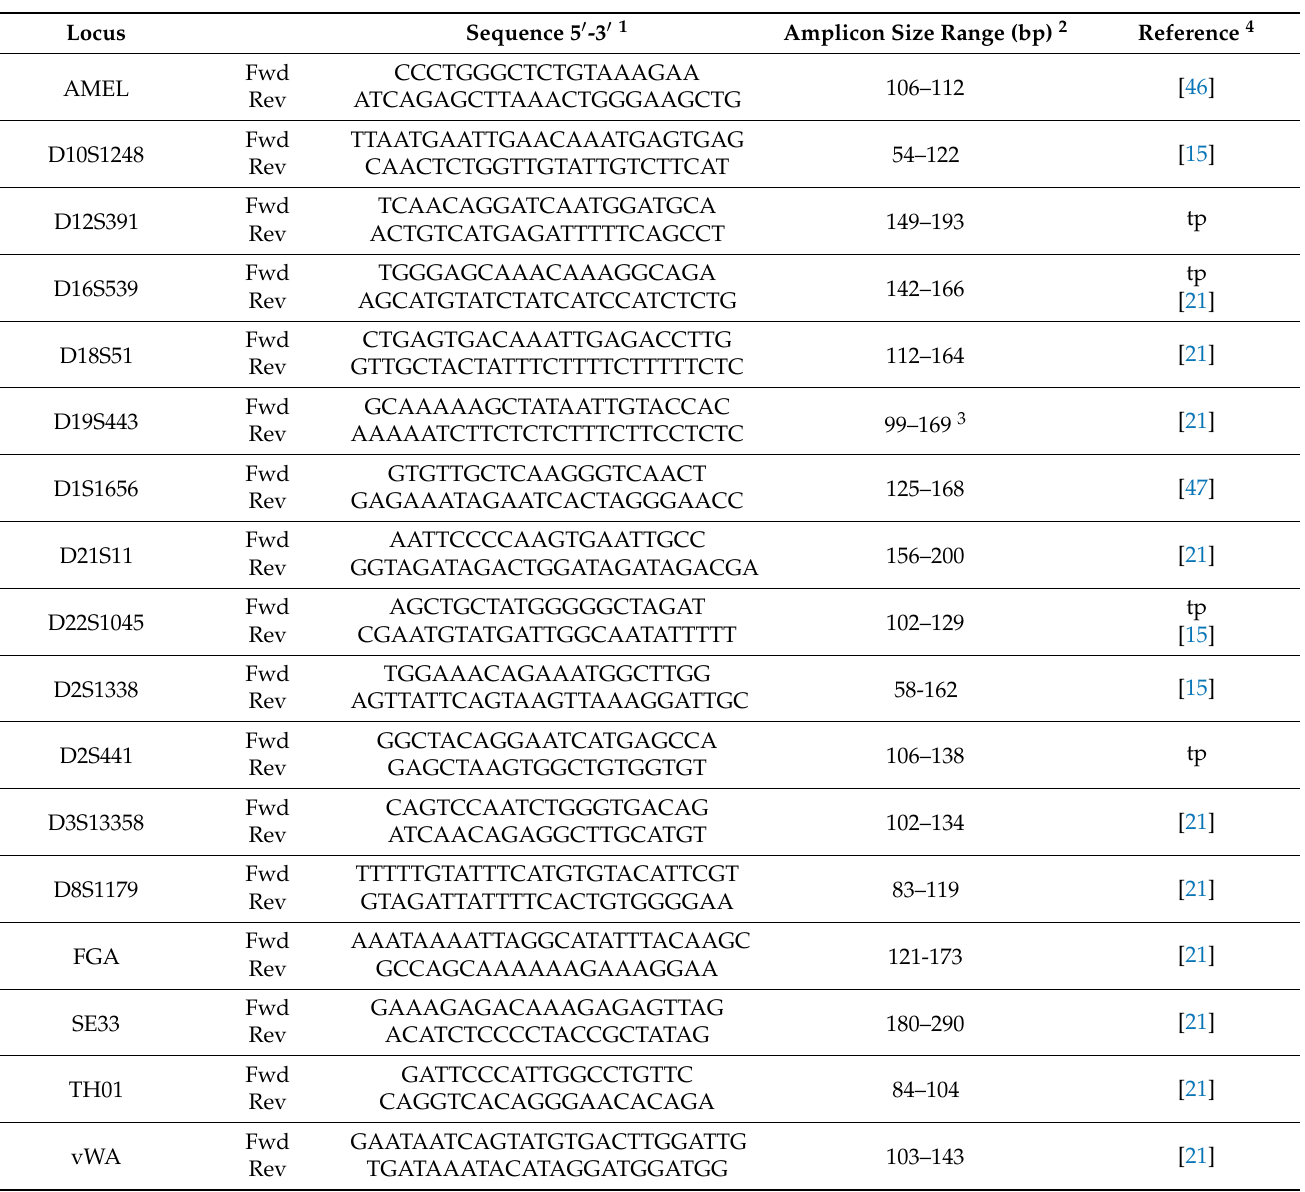
Table 3. Primers used for the MaSTR